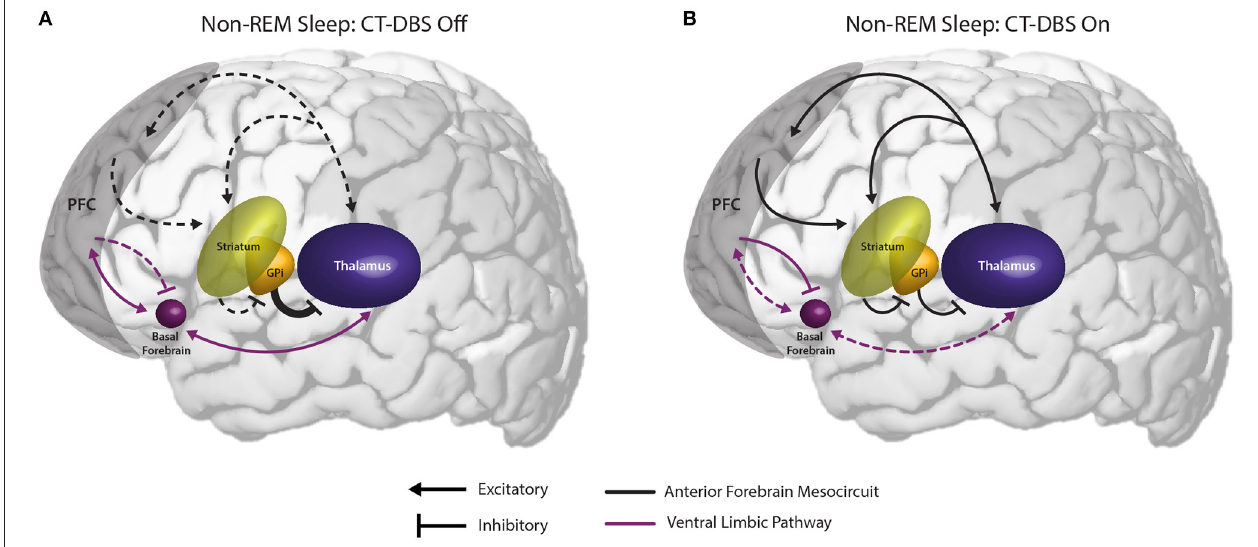
FIGURE 6 | Proposed mechanism linking the observed effects of CT-DBS in our patient subject with anterior forebrain mesocircuit function and the generation of alpha-delta sleep. (A) Anterior forebrain mesocircuit dysfunction in disorders of consciousness. In severe brain injury, widespread deafferentation results in functional downregulation of the prefrontal cortex (PFC) via functional disfacilitation and structural deafferentation of central thalamic neuronal populations (30). Under these conditions, medium spiny neurons of the striatum fail to reach firing threshold, resulting in released inhibition of the globus pallidus interna (GPi). Excess firing of the GPi is proposed to result in additional inhibition of central thalamic components, preventing sufficient thalamocortical output, and tilting the excitatory/inhibitory balance needed for the consistent maintenance of consciousness [see Schiff ( 30)]. Such reduced activation of the PFC during wake may result in insufficient accumulation of homeostatic sleep pressure and correspondingly under-activated prefrontal GABAergic networks during sleep. Failure to inhibit ventral limbic structures such as the basal forebrain would result in excess activation of thalamocortical cells and the intrusion of alpha oscillations during SWS. (B) Restoration of mesocircuit function and alpha-delta sleep alleviation during CT-DBS. CT-DBS drives thalamocortical output, resulting in restored wakeful excitation of the PFC. Increased PFC engagement during wakefulness produces an accumulation of homeostatic sleep pressure, facilitating the inhibition of ventral limbic structures during sleep via upregulation of SWS-producing GABAergic interneurons. Without excess thalamic activation by ventral structures during SWS, depolarization necessary for alpha-producing high threshold thalamocortical bursting is not achieved and alpha-delta sleep does not occur. Image adapted from The Allen Human Brain